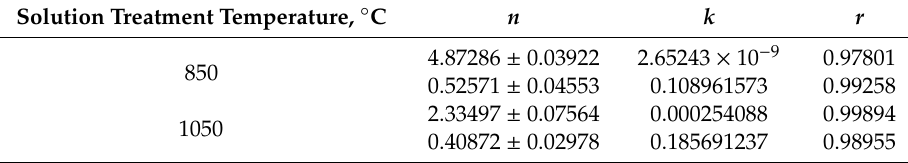
Table 3. The Johnson–Mehl–Avrami–Kolmogorov (JMAK) parameters ( n and k ) and the correlation coe ffi cients ( r ) of linear fits at 500 ◦ C obtained by the plots of ln [ − ln (1 − f α ( t ) / f max α ] versus ln ( t ) for 1050 ◦